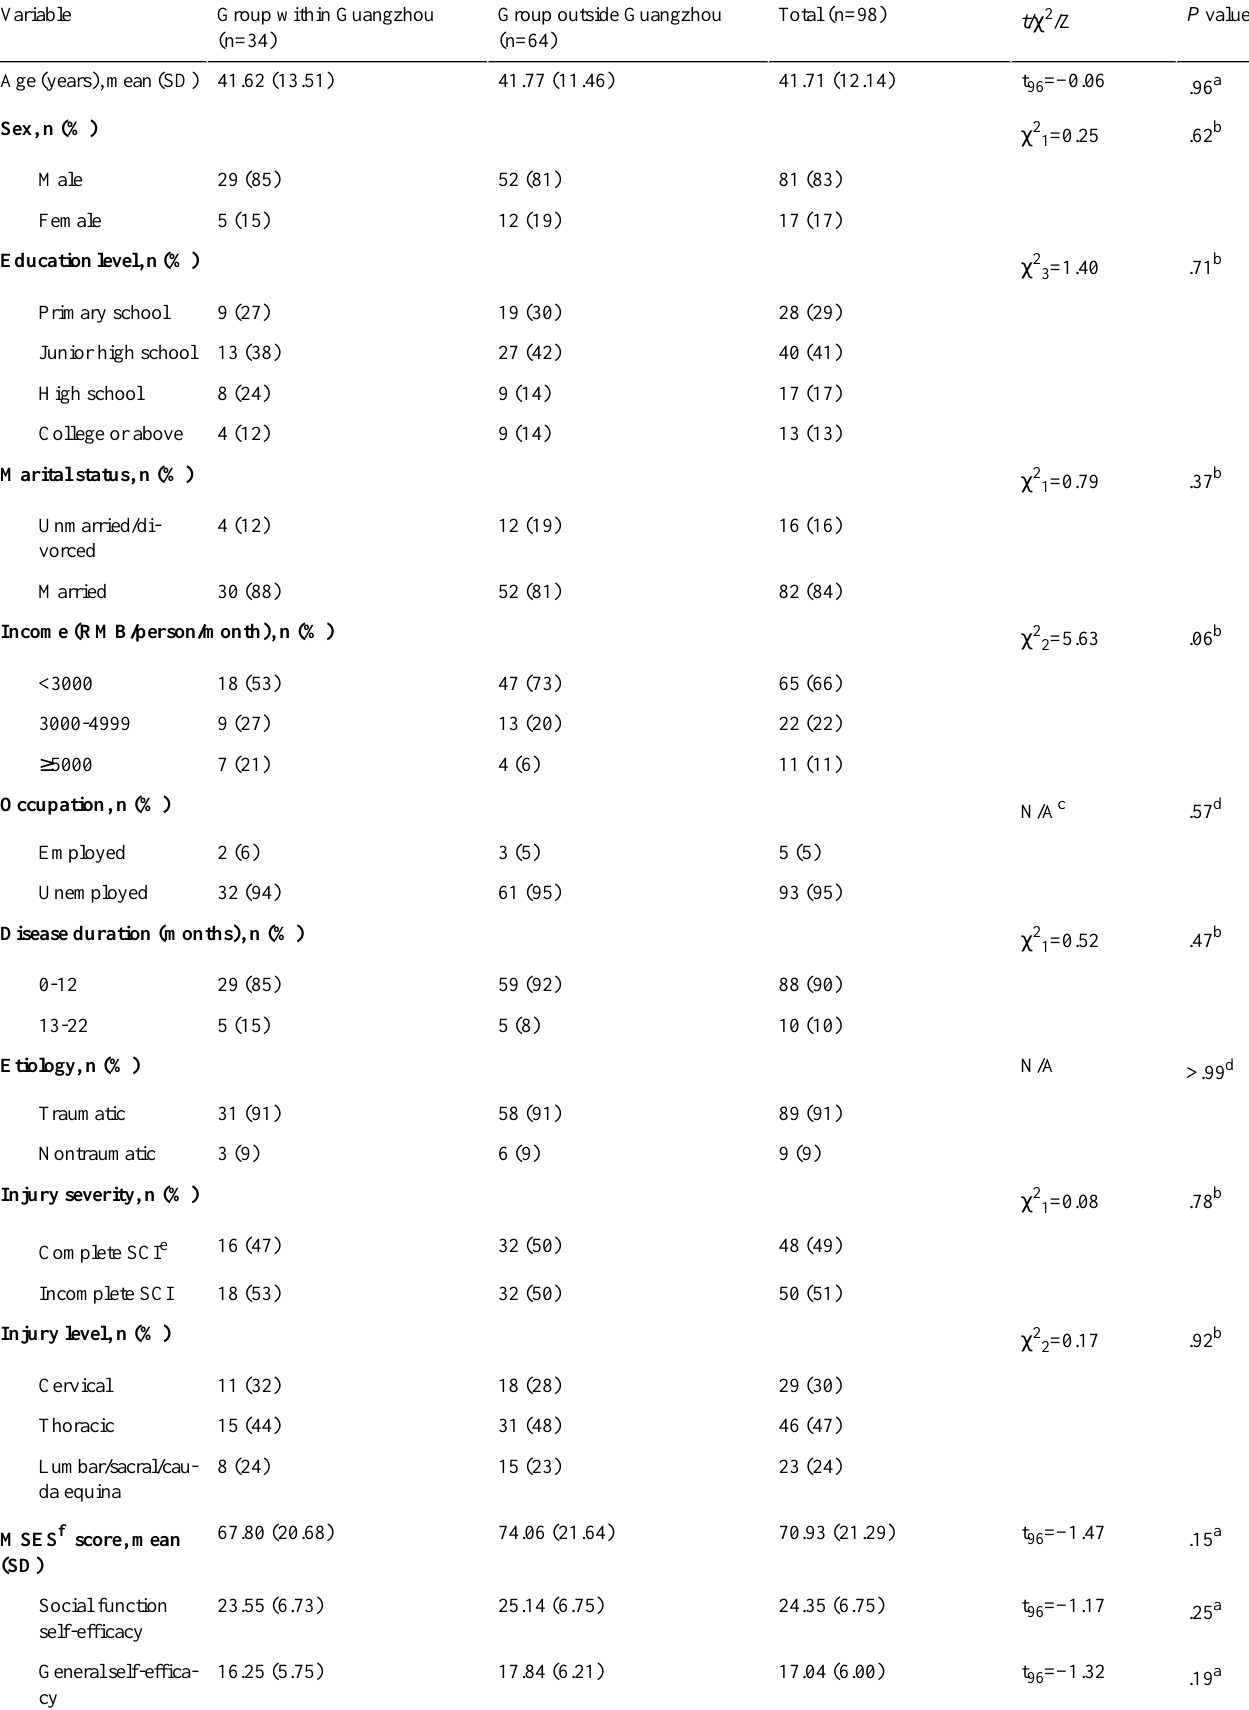
Table 2. Balance test between the group within Guangzhou and the group outside Guangzhou (T 0